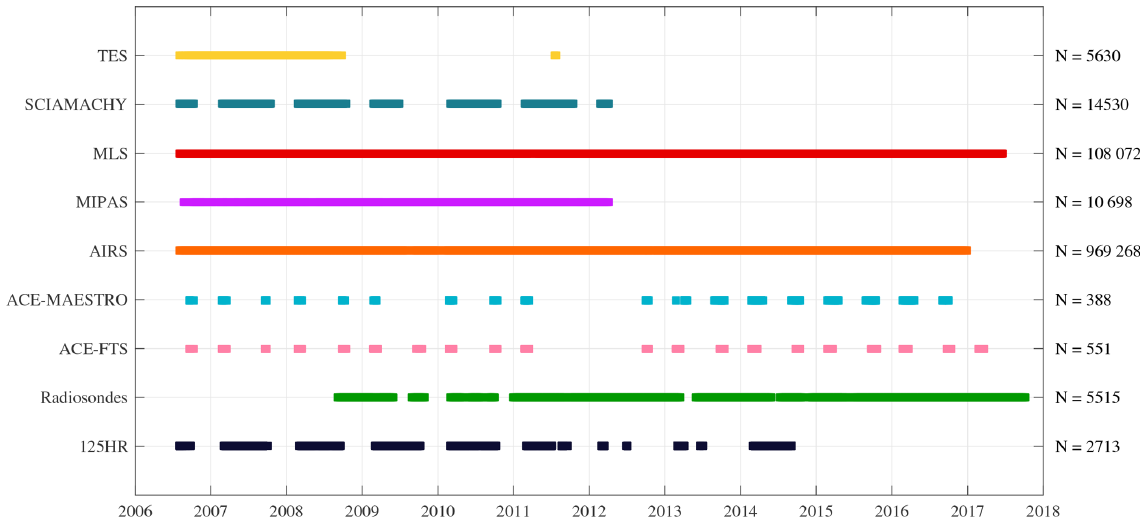
Figure 1. Temporal range of datasets used in this study. N is the number of